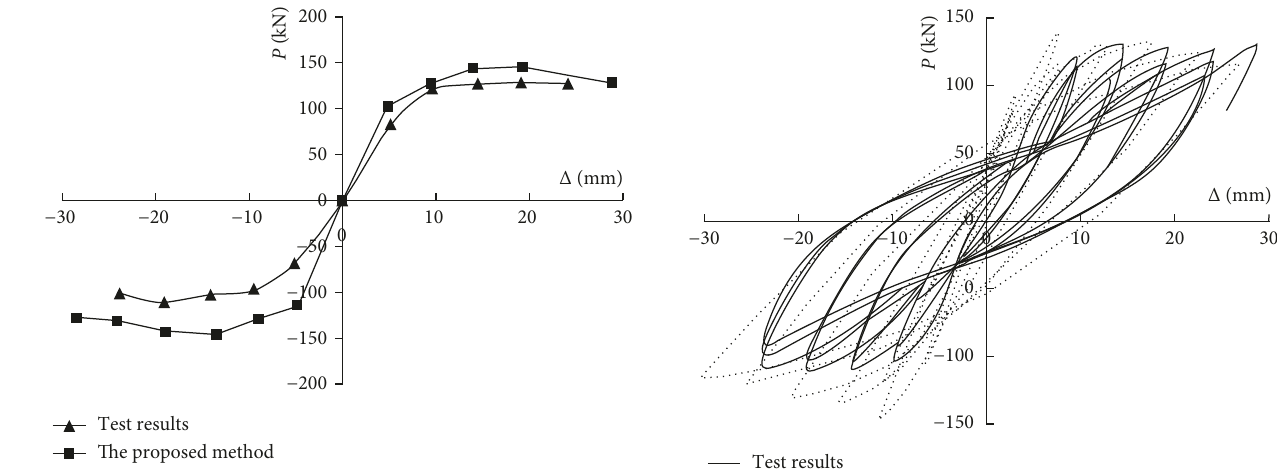
Figure 6: Skeleton curves on top floor of the specimen.